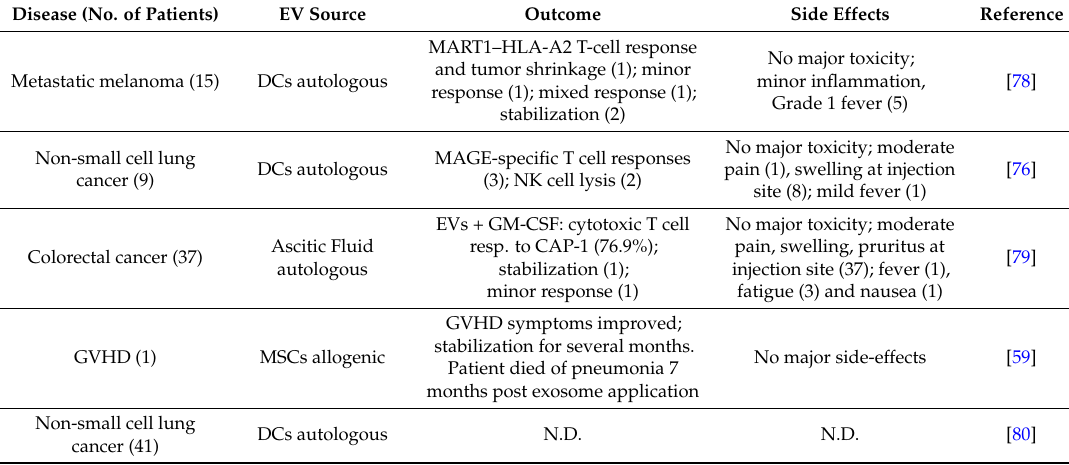
Table 3. Published clinical trials on EV-based therapies-modified from Ohno et al. [77]. Disease (No. of